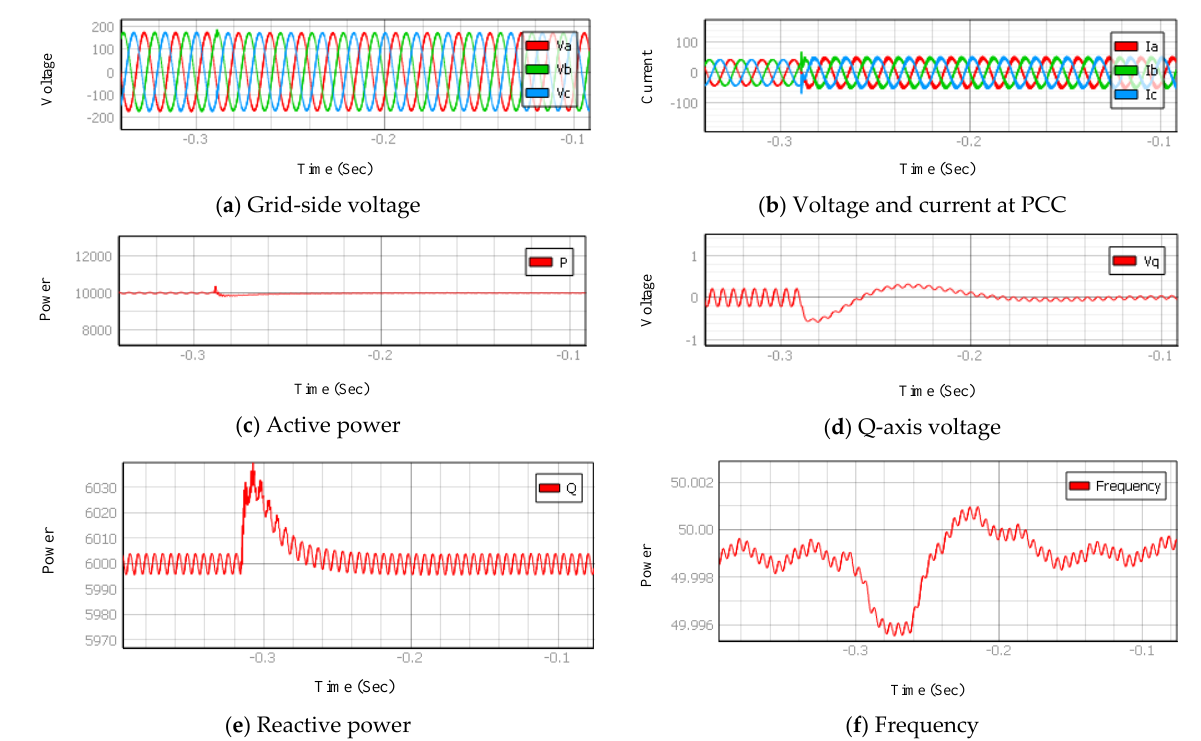
Figure 17. Characteristics of the DG system during grid synchronization from islanding mode.